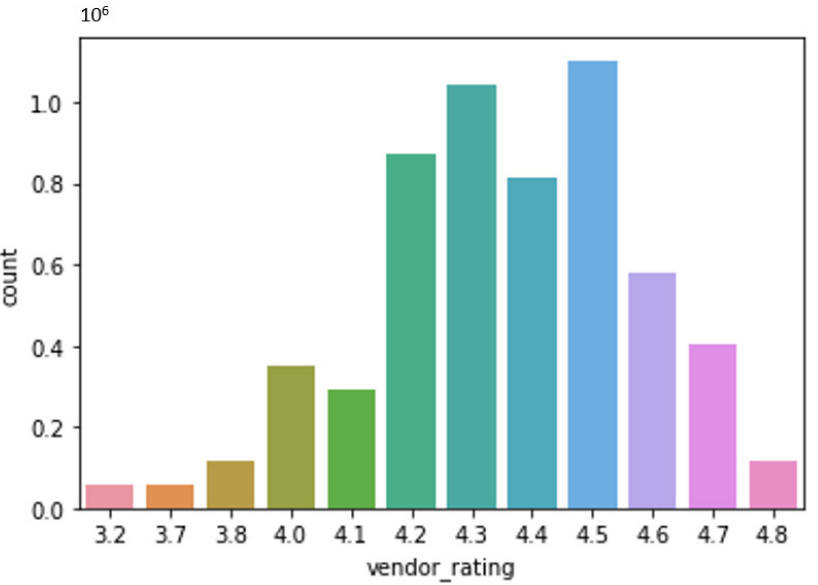
Figure 29. Distribution map of restaurant rating dataset.